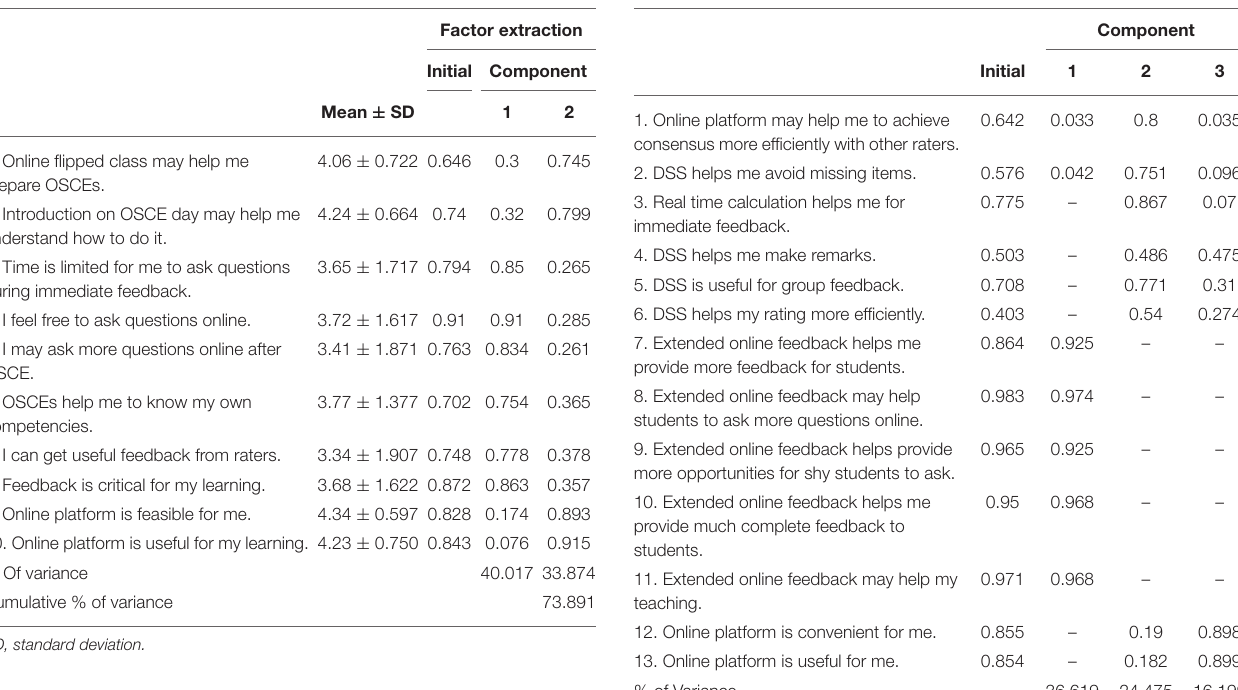
TABLE 3 | Factor analysis affecting the students’ perceptions. TABLE 4 | Factor analysis affecting the teachers’